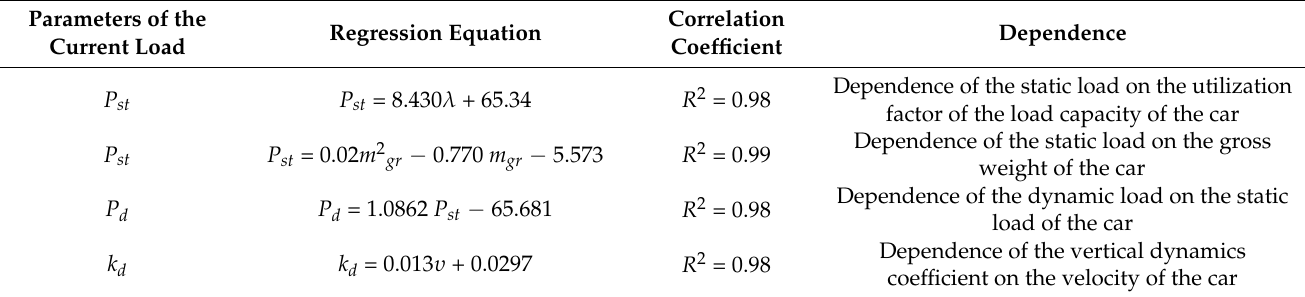
Table 4. Regression equation of the studied dependencies of the dynamic load after the restoration of coverage. Parameters of the Regression Equation Current Load